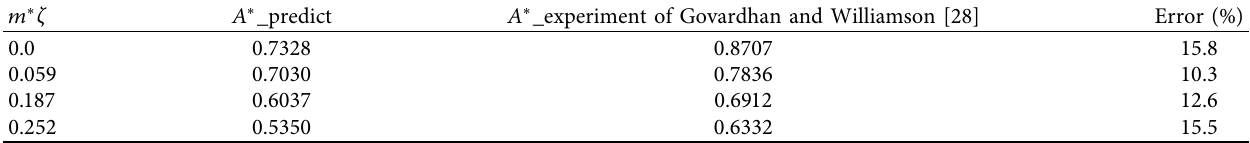
Table 7: Comparison of A ∗ at λ ∗ � 6 . 0 with experiment results.